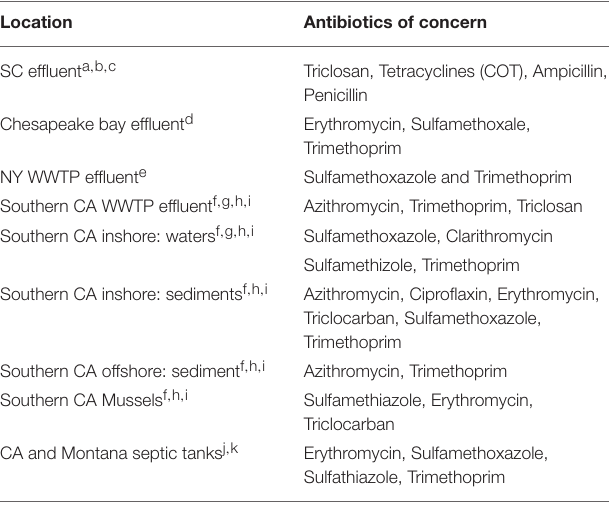
TABLE 1 | Comparison of antibiotics of concern detected in different regions of the US.